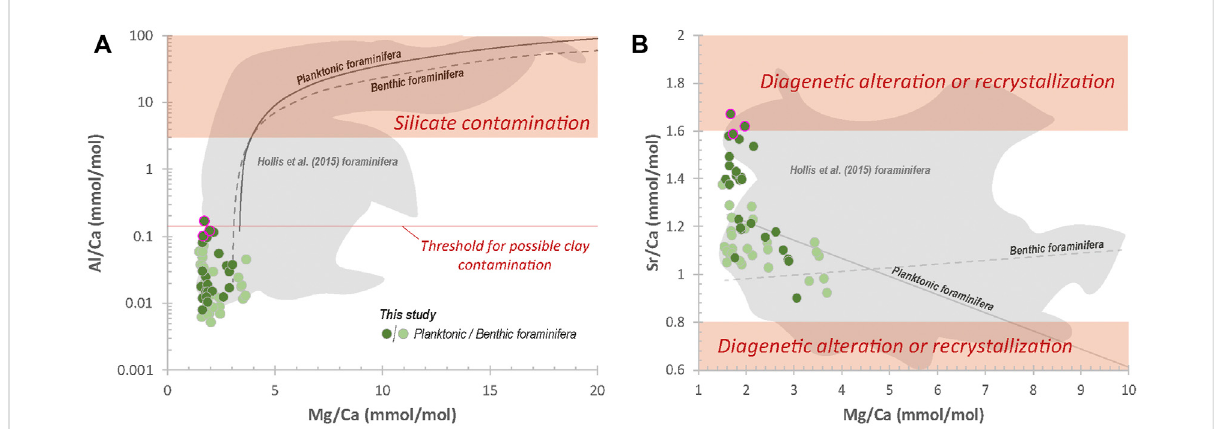
FIGURE 5 (A) Cross-plots ofAl/CavsMg/Caratiosand (B) Sr/CavsMg/Ca ratiosmeasuredintheforaminiferalfractions.Screeninglimitsinshadedredare fromHollisetal.(2015).AnotherAl/CaratiothresholdforpotentialclaycontaminationfromRaeetal.(2011)andHenehanetal.(2020)isrepresented (red line in a). Shaded grey domains and grey trend lines represent the LA-ICP-MS data of Hollis et al. (2015) on benthic and planktonic foraminifera from the Site 277 for comparison. The samples highlighted in pink are the three samples slightly above the contamination threshold for Al/Ca and Sr/Ca molar ratios.